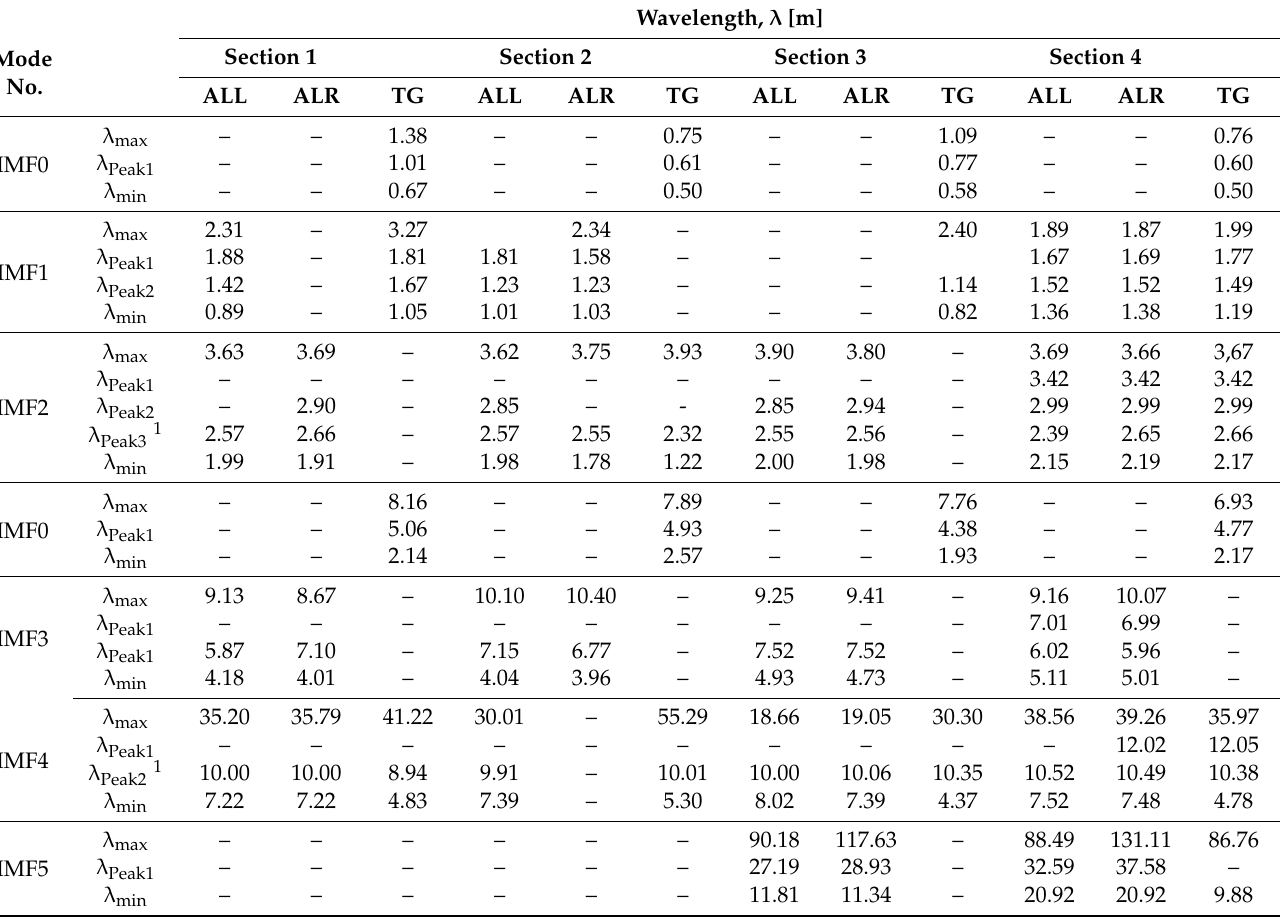
Table 8. Wavelength ranges in the IMF components of ALL, ALR, and TG calculated by